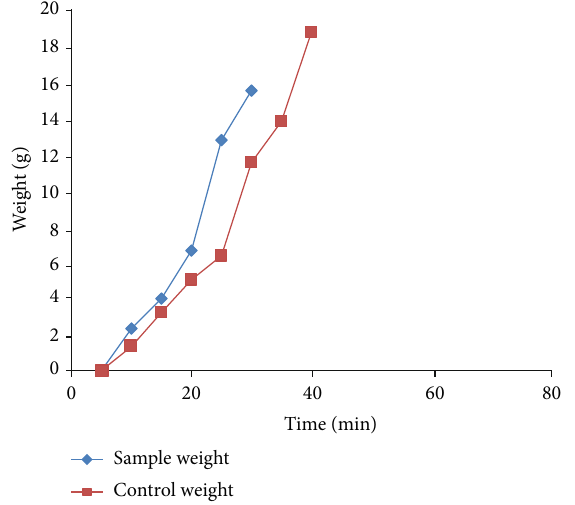
Figure 2: Comparison of melting rates of the spicy coconut ice cream with normal coconut ice cream.